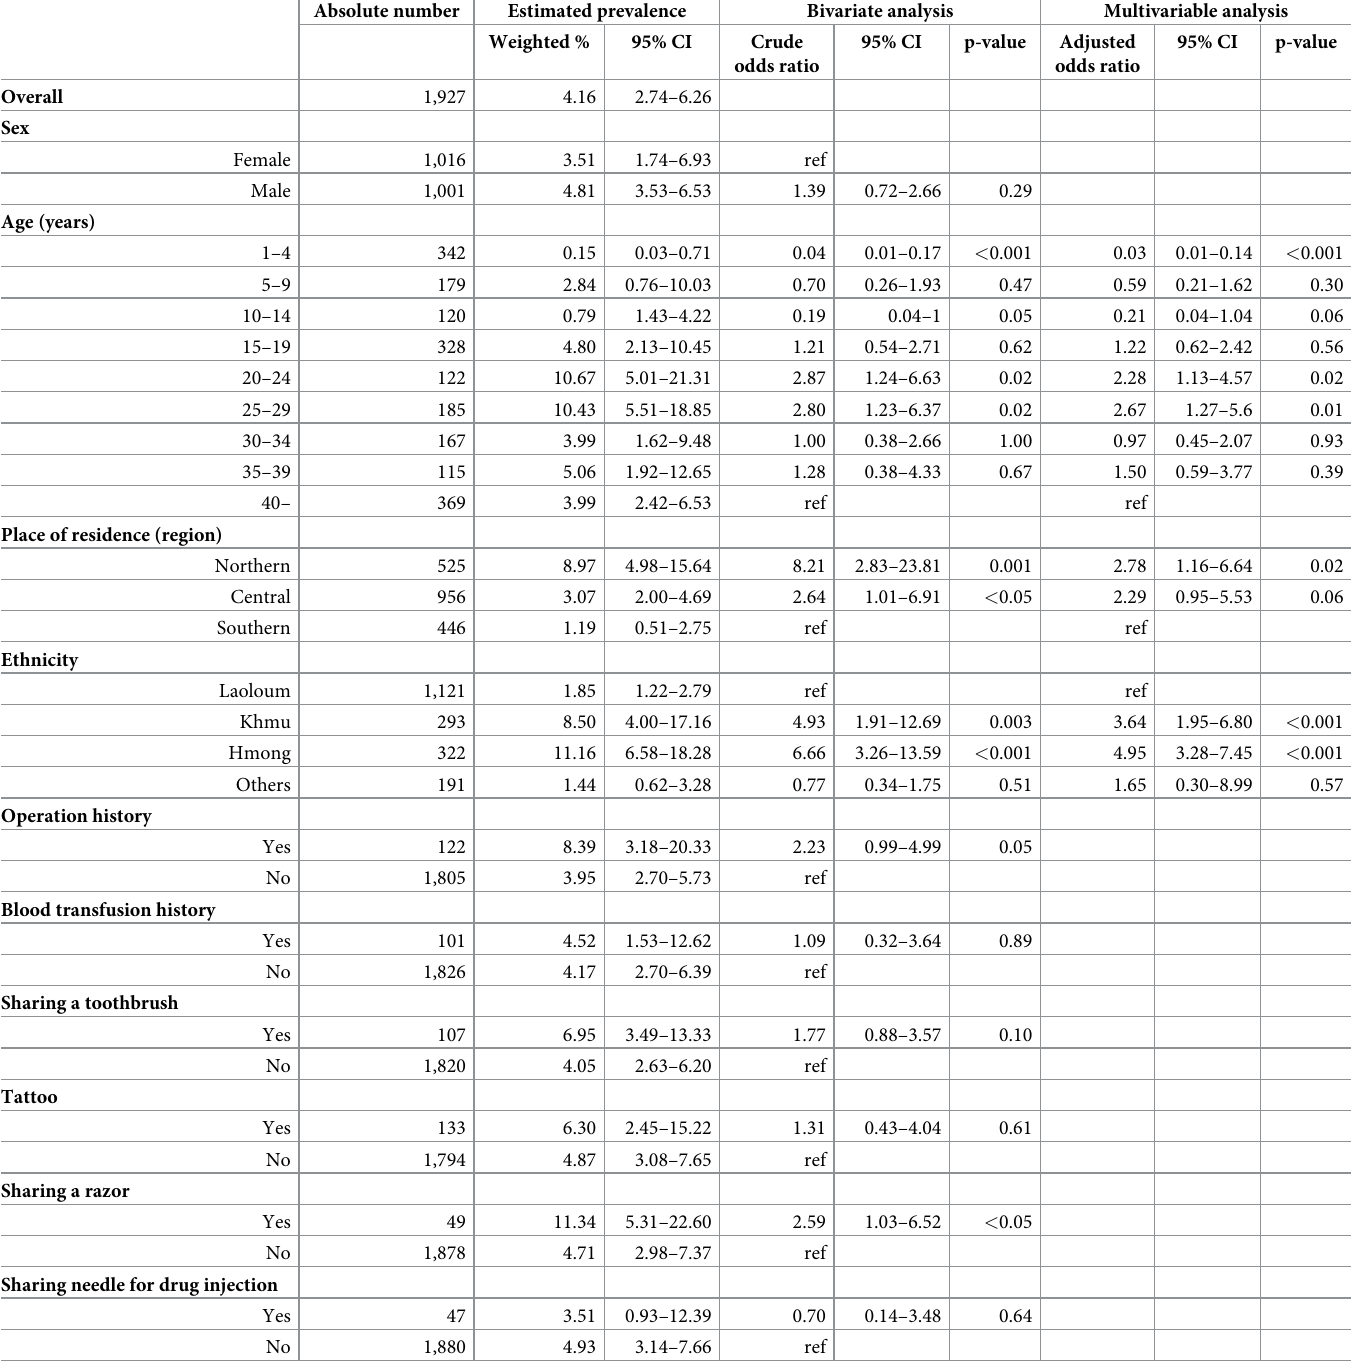
Table 2. Estimated prevalence of HBsAg and its risk factor